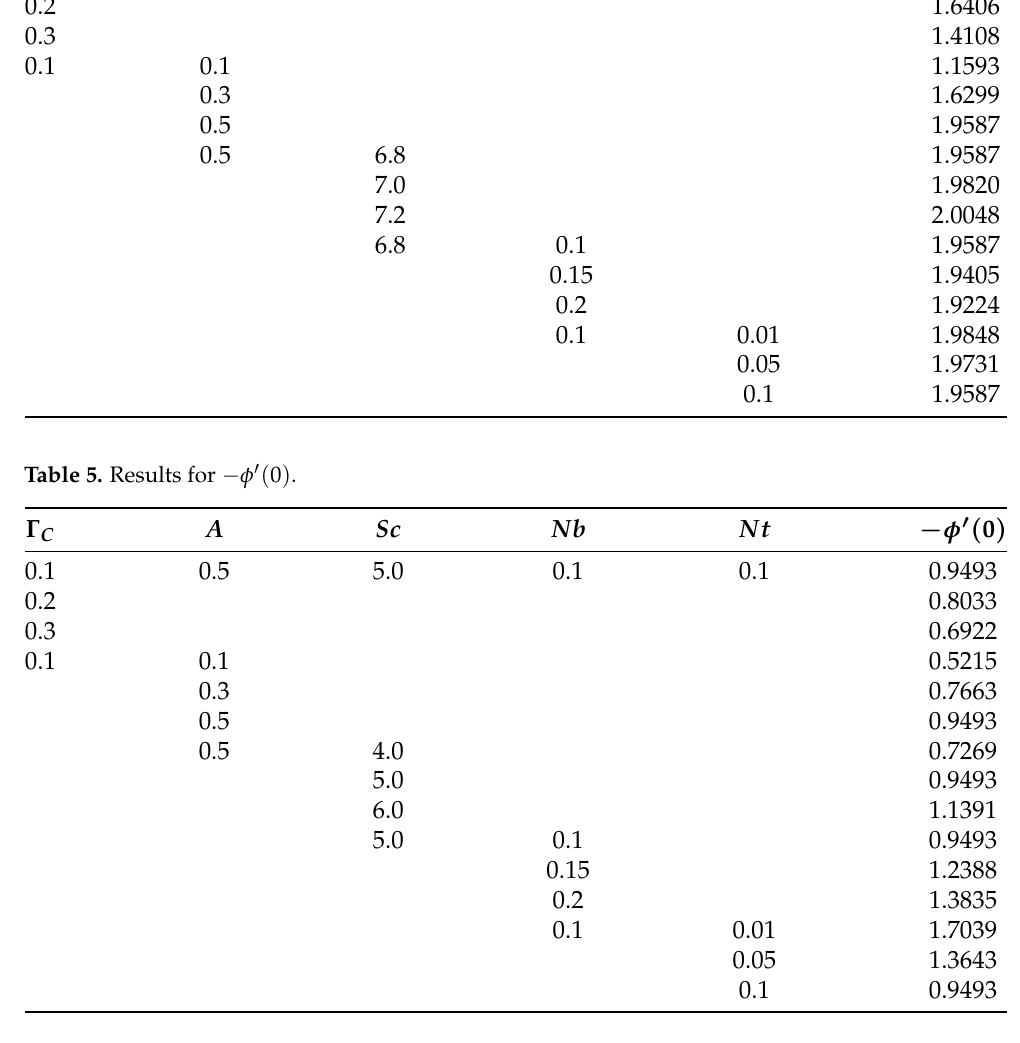
Table 6. Results for − χ (cid:48) ( 0 )